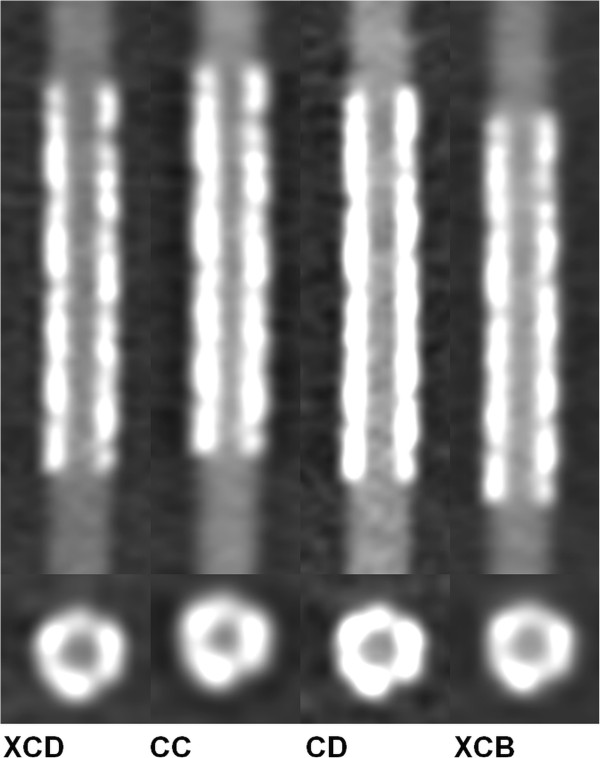
Differences of reconstruction kernels. Reconstructions of the same stent applying the four different kernels. (B. Braun Coroflex Please, nominal diameter 3.0 mm, length 19 mm).